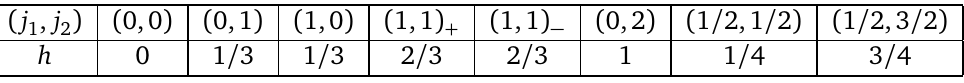
Table 5: Anyons and their conformal dimensions for the theory SO ( 4 )